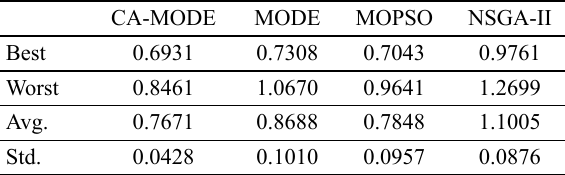
Table 6. Comparison of SP-metric for different algorithms